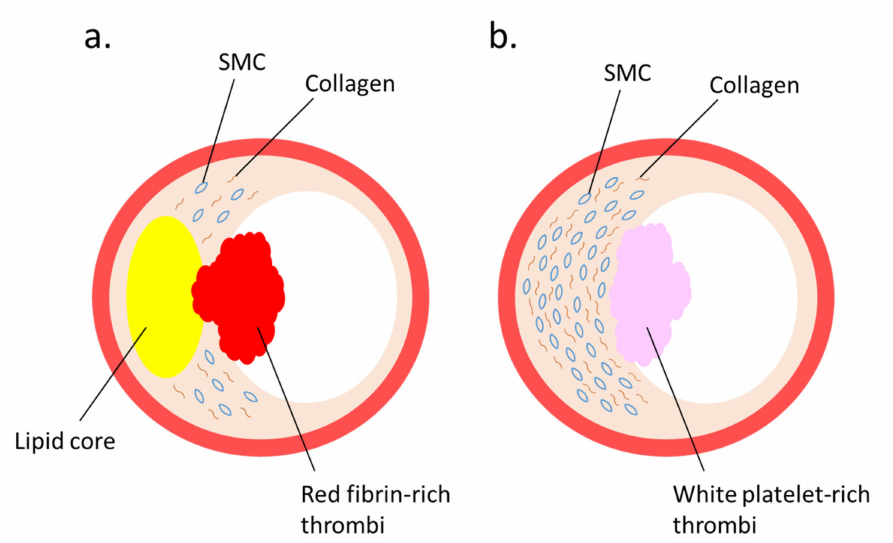
Figure 2. Two major lesions that lead to thrombus formation: ( a ) plaque rupture and ( b ) plaque erosion—are illustrated. ( a ) A vulnerable plaque is characterized by a large lipid core covered by a thin fibrous cap. When the fibrous cap is ruptured, red thrombus is produced. ( b ) A plaque erosion is characterized by a thickened intima enriched with smooth muscle cells (SMCs) and collagen fibers. When endothelial cells are injured, white-platelet-rich thrombus is